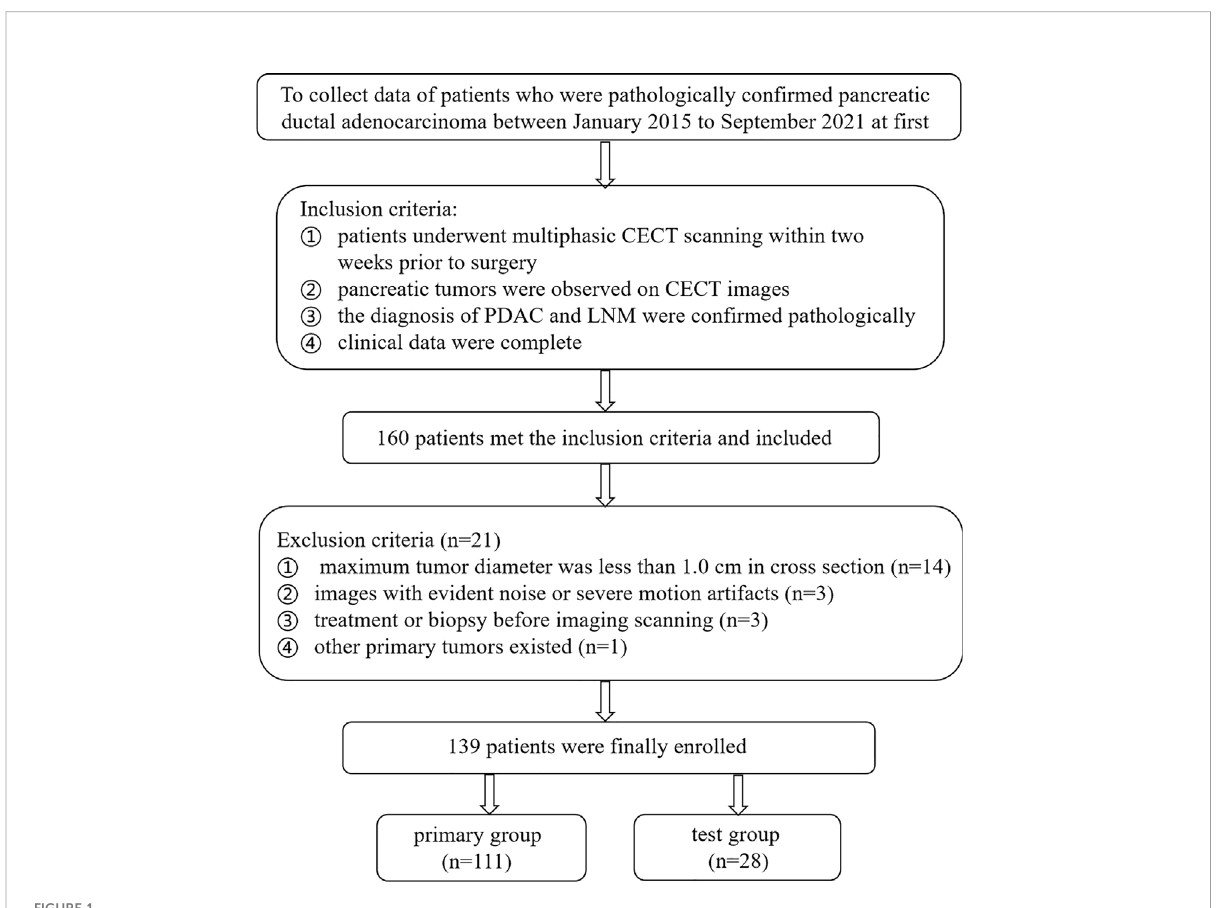
FIGURE 1 Flow chart of patient ’ s